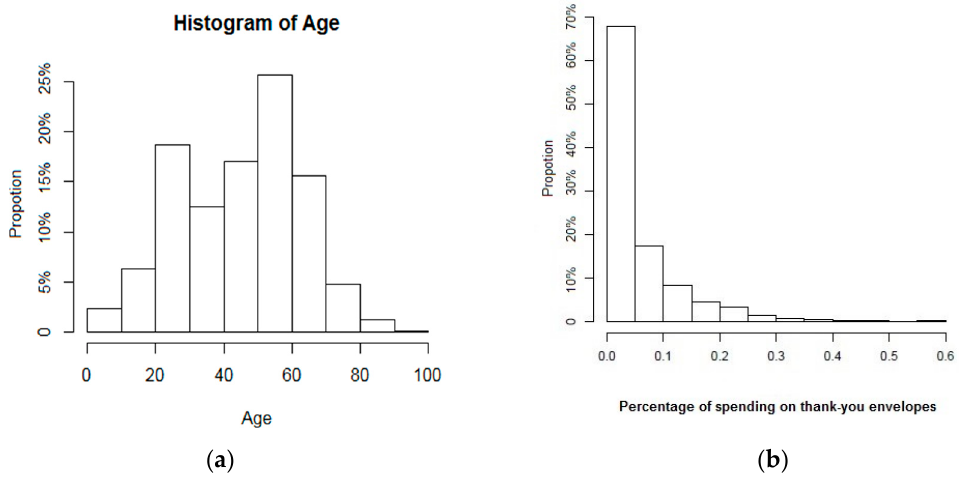
Figure 1. Distribution of patients towards ( a ) age and ( b ) the proportion of thank-you money in total treatment fee.